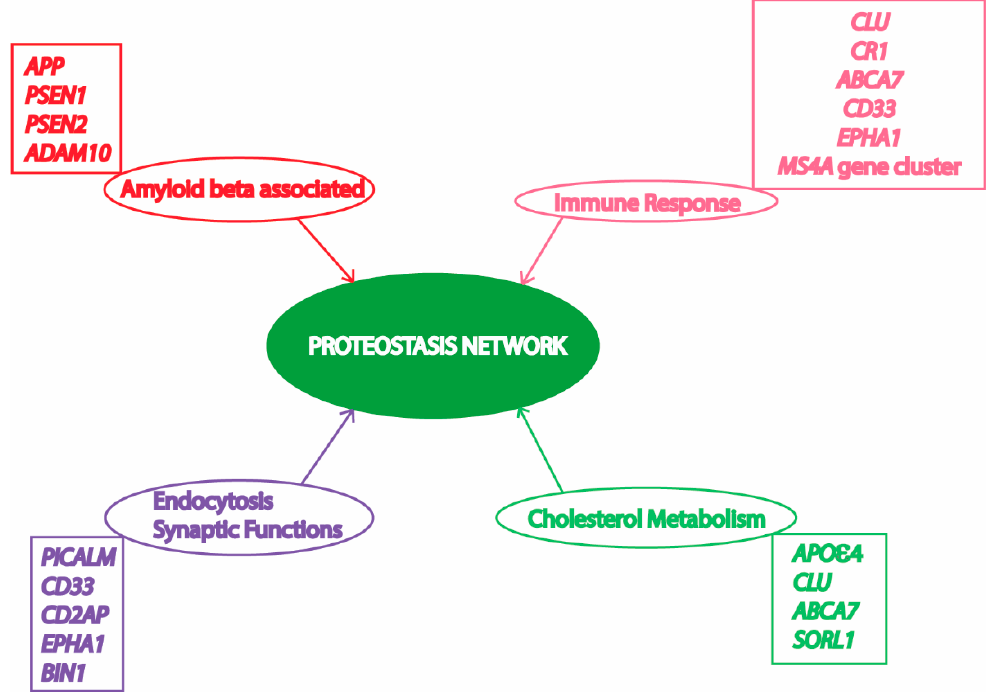
Figure 1. Risk factors / loci and associated cellular processes identified by genome wide association studies (GWAS) involved in Alzheimer’s Disease (AD) converge to the proteostasis network. APP, amyloid precursor protein; PSEN1, presenilin 1; PSEN2, presenilin 2; ADAM10, ADAM metallopeptidase domain 10; CLU, clusterin; CR1, complement C3b/C4b receptor 1; ABCA7, ATP binding cassette subfamily A member 7; CD33, CD33 molecule; MS4A, membrane spanning 4-domains A; PICALM, phosphatidylinositol binding clathrin assembly protein; CD2AP, CD2 associated protein; EPHA1, EPH receptor A1; BIN1, bridging integrator 1; APO ε 4, apolipoprotein E4; SORL1, sortilin related receptor 1. Various risk loci have been identified by GWAS to be associated with AD. Some of these risk loci are clustered to important cellular processes in this figure to depict their relationship with the proteostasis network, highlighting its significance in AD pathology. Previous studies suggest an important role of the proteostasis network in cellular processes associated with AD, including amyloid formation pathway, immune response mechanisms, vesicle trafficking, endocytosis, and lipid metabolism.